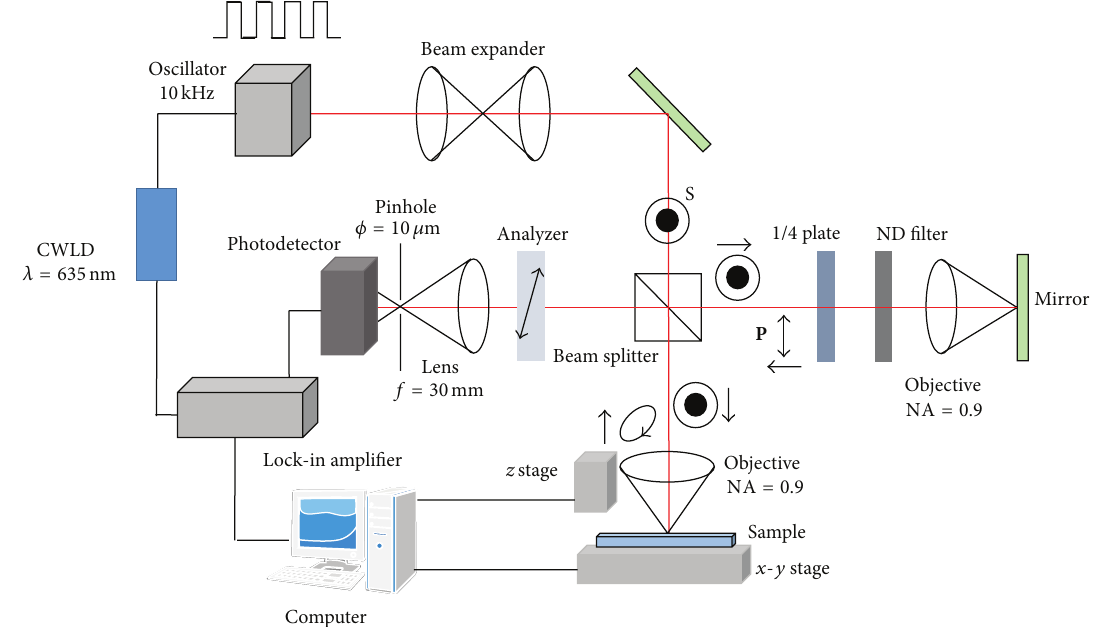
Figure 2: Optical setup for a polarization interferometric nonlinear confocal